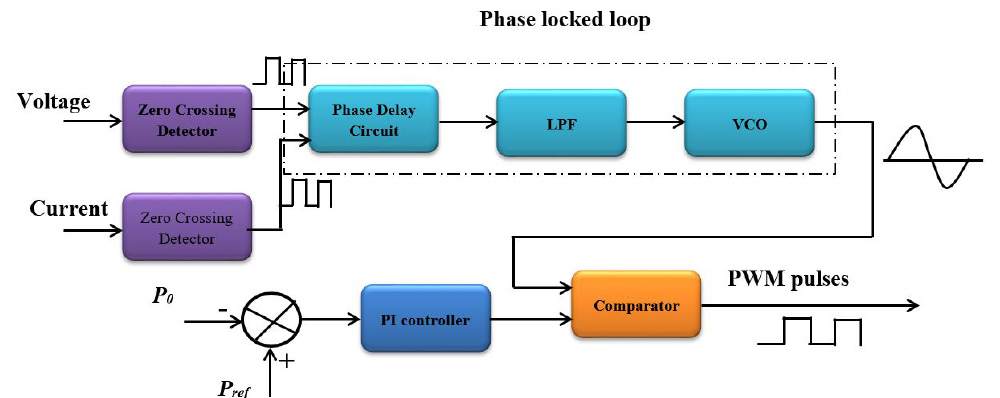
Figure 11. A general block diagram of PLL-aided PI control.